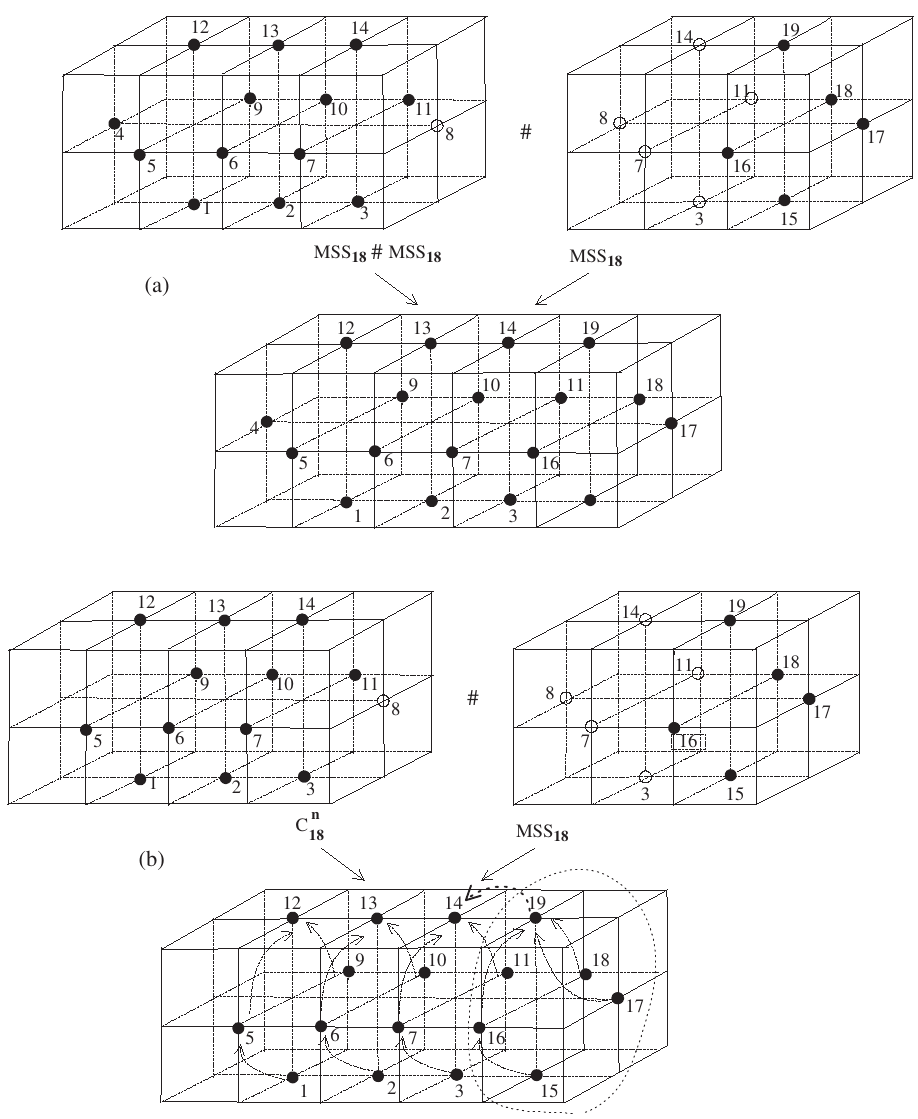
(cid:93) MSS : = C 2 18 . ( b ) Configuration of an 18 18 , m (cid:48) ≥ 18